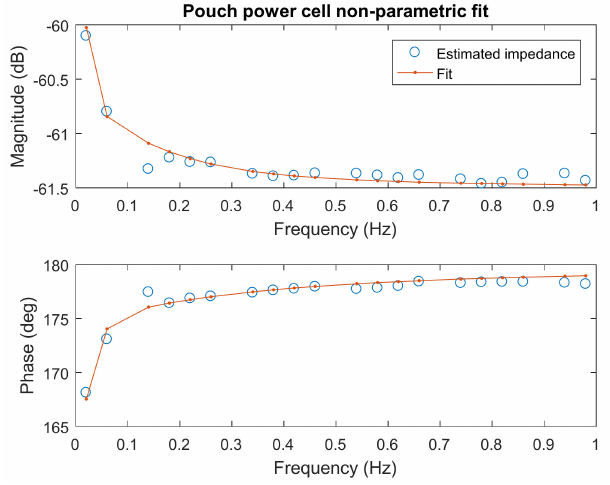
Figure 4. Example of a non-parametric fit for a pouch power cell at 20% state of charge